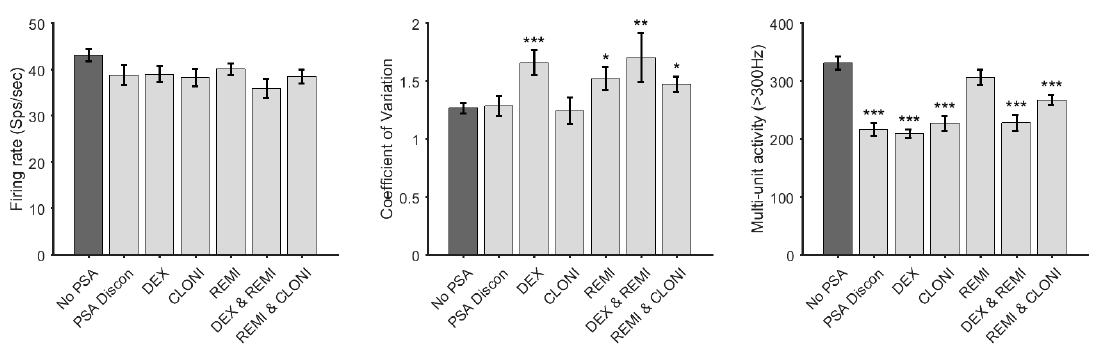
Figure 3. Bar plot (error bars show standard error) and t-test for the No PSA group against each PSA group for firing rate, coefficient of variation and multi-unit activity. * p < 0.05, ** p < 0.01, *** p < 0.001. CLONI: clonidine; DEX: dexmedetomidine; REMI: remifentanil; PSA: procedural sedation and analgesia.